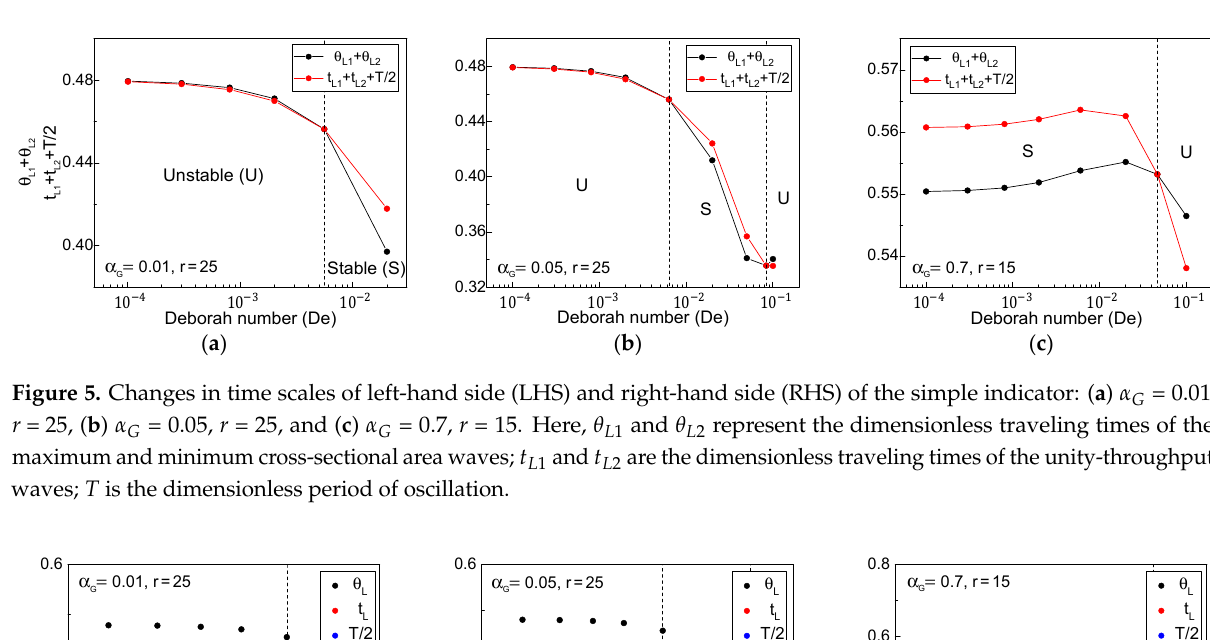
t ) and maximum/minimum cross-sectional area wave ( L α = 0.01, r = 25, ( b ) α = 0.05, r = 25, and ( c ) α = 0.7, r = 15. G G G